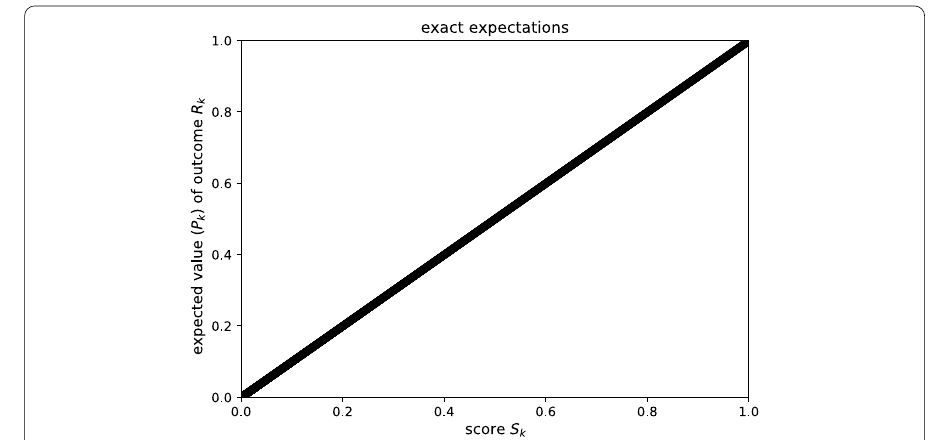
Fig. 47 Ground-truth reliability diagram for Fig. 46